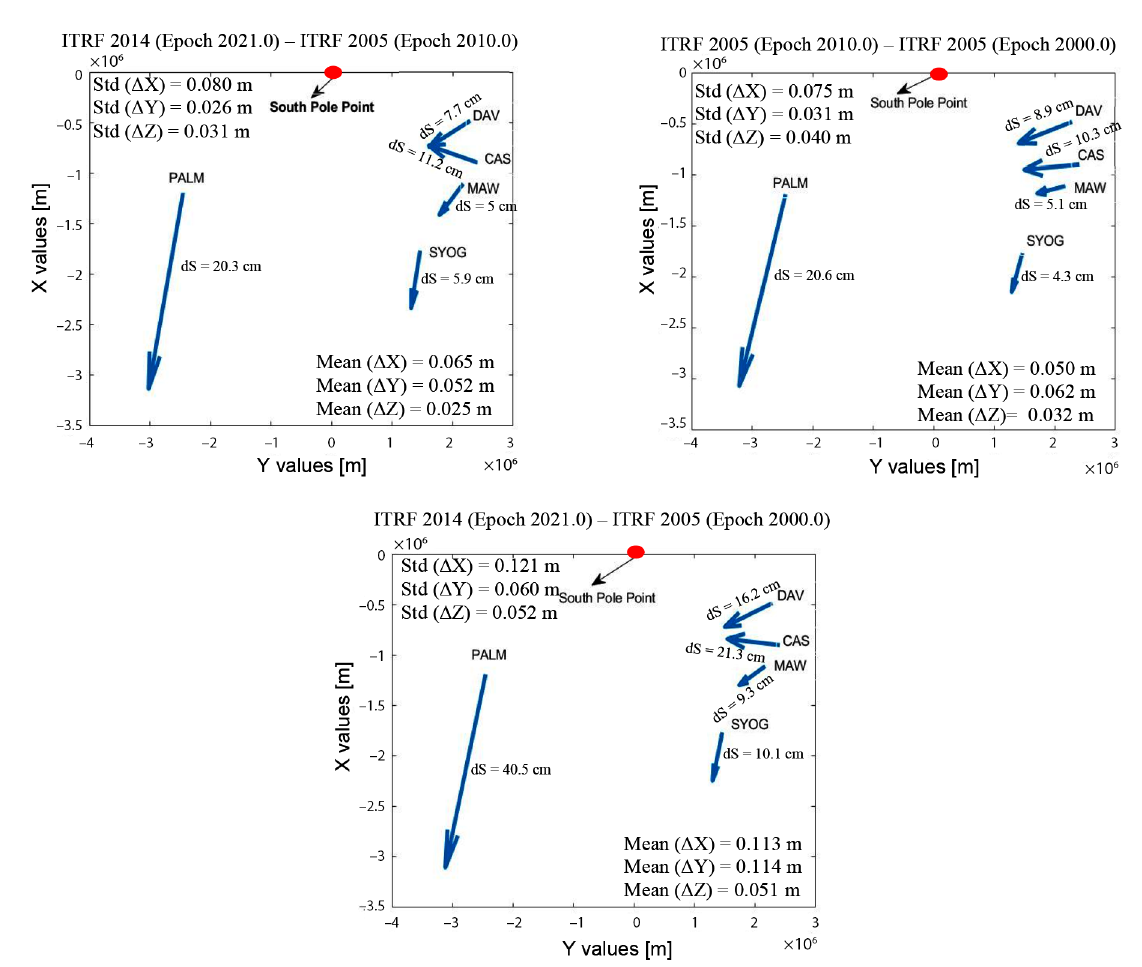
Figure 5. Horizontal displacement vectors (WGS 84 coordinate system) of the five IGS points (South Pole Region) among three periods (1 January 2021, 1 January 2010, 1 January